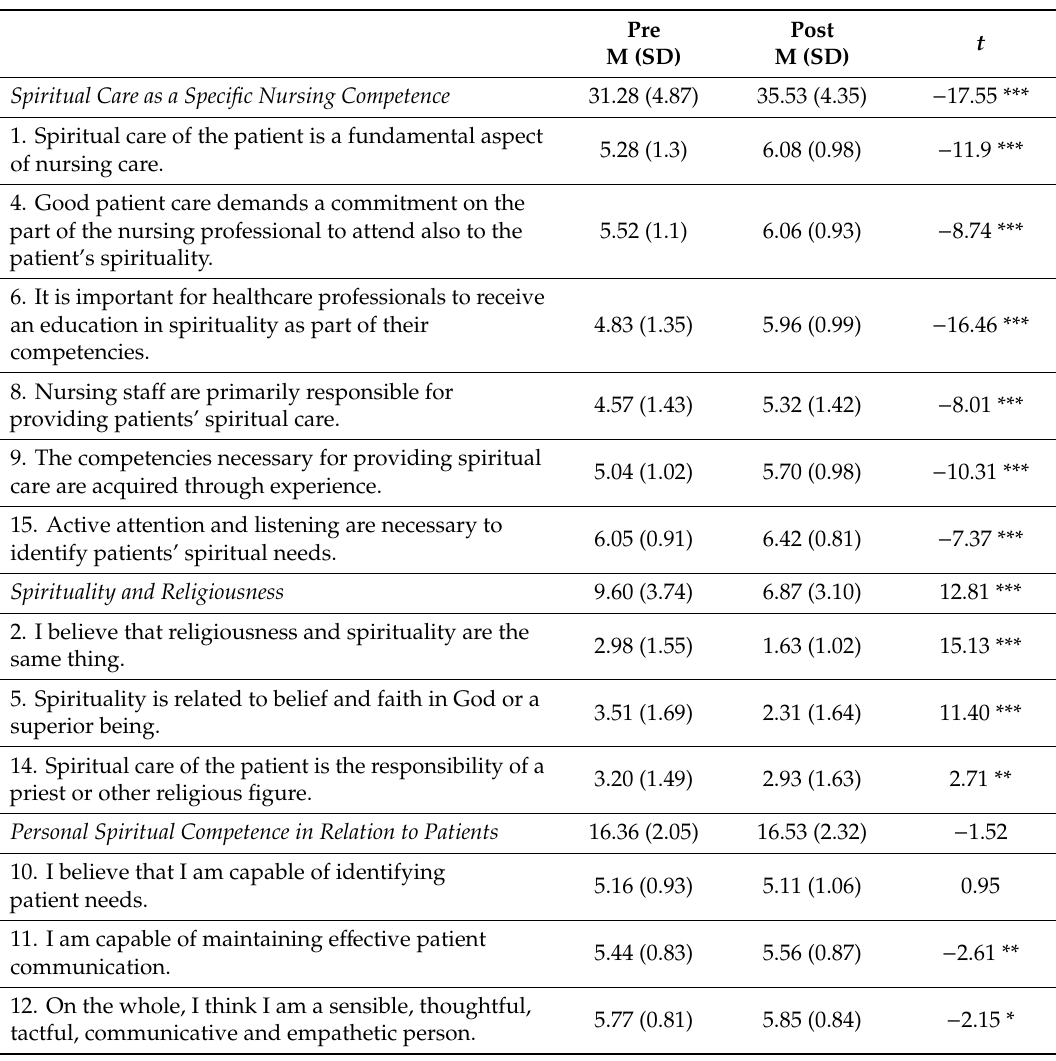
Table 3. Descriptive and di ff erential pre-post analysis of the Nursing Students’ Spirituality Training Questionnaire